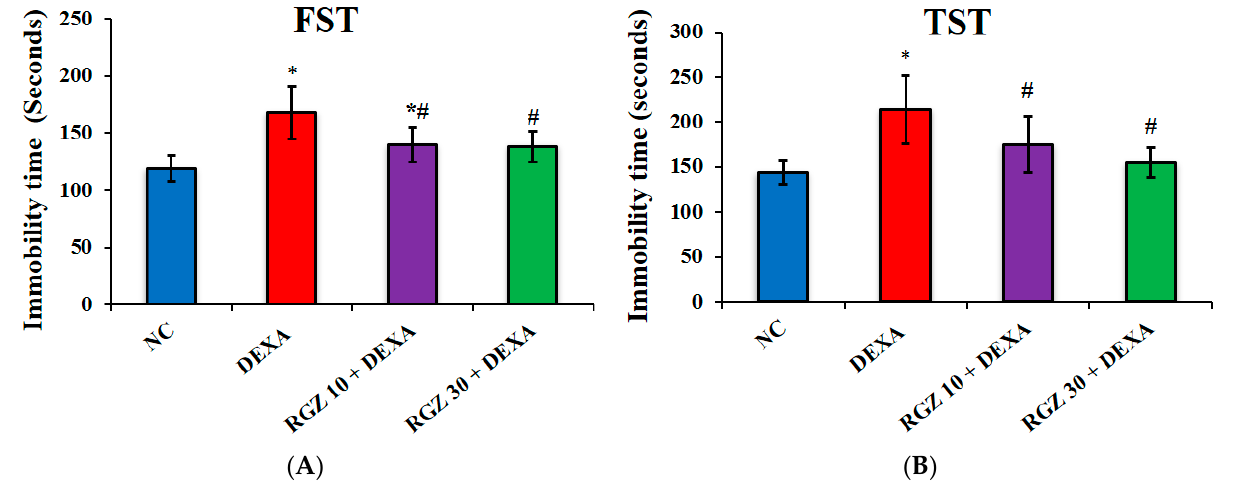
Figure 1. Effect of administration of DEXA, 20 mg/kg; s.c., RGZ, 10 mg/kg, or 30 mg/kg p.o. on the behavioral activity of FST ( A ) and TST ( B ) in mice. The statistical evaluation was conducted by a one-way ANOVA and then Tukey’s post hoc test. The values are represented by the mean ± SD ( n = 8). NC—normal control; DEXA—dexamethasone; RGZ—rosiglitazone; FST—forced swimming test; TST—tail suspension test. A significant difference was considered at p < 0.05 and distinguished by * vs. NC; # vs. DEXA.